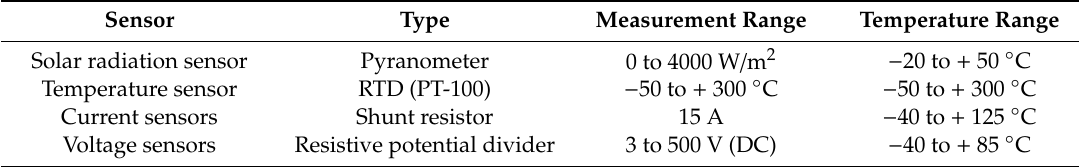
Figure 1. Schematic block circuit diagram of the PV system with sensors and measuring points.